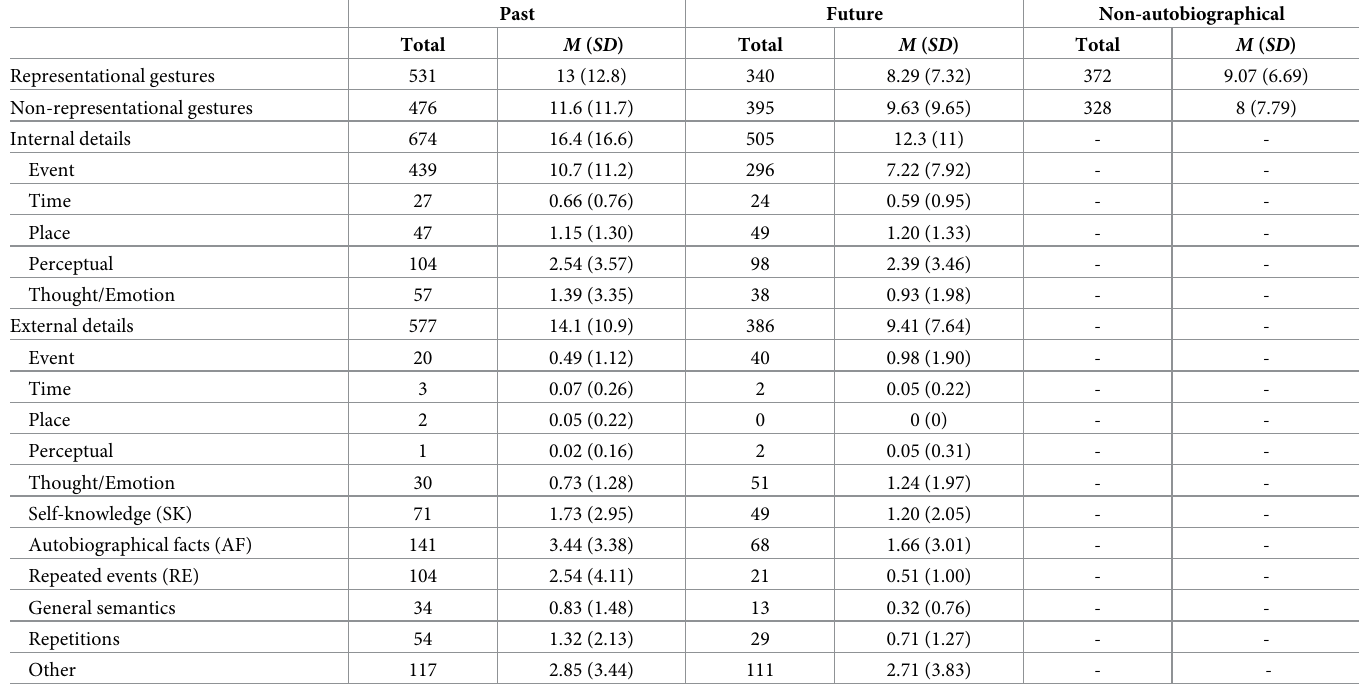
Table 1. Means and standard